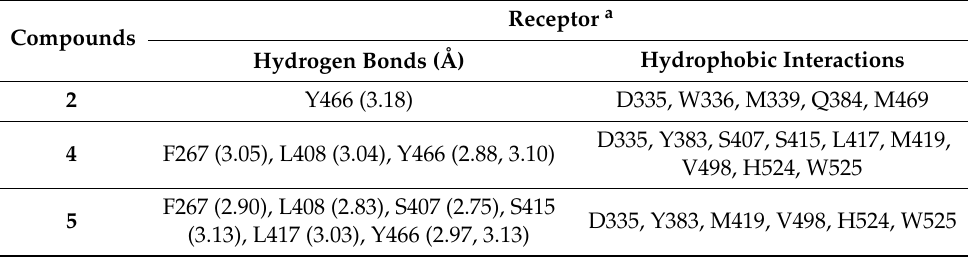
Table 2. Pharmacophore analysis between sEH and compounds 2 , 4 , and 5.